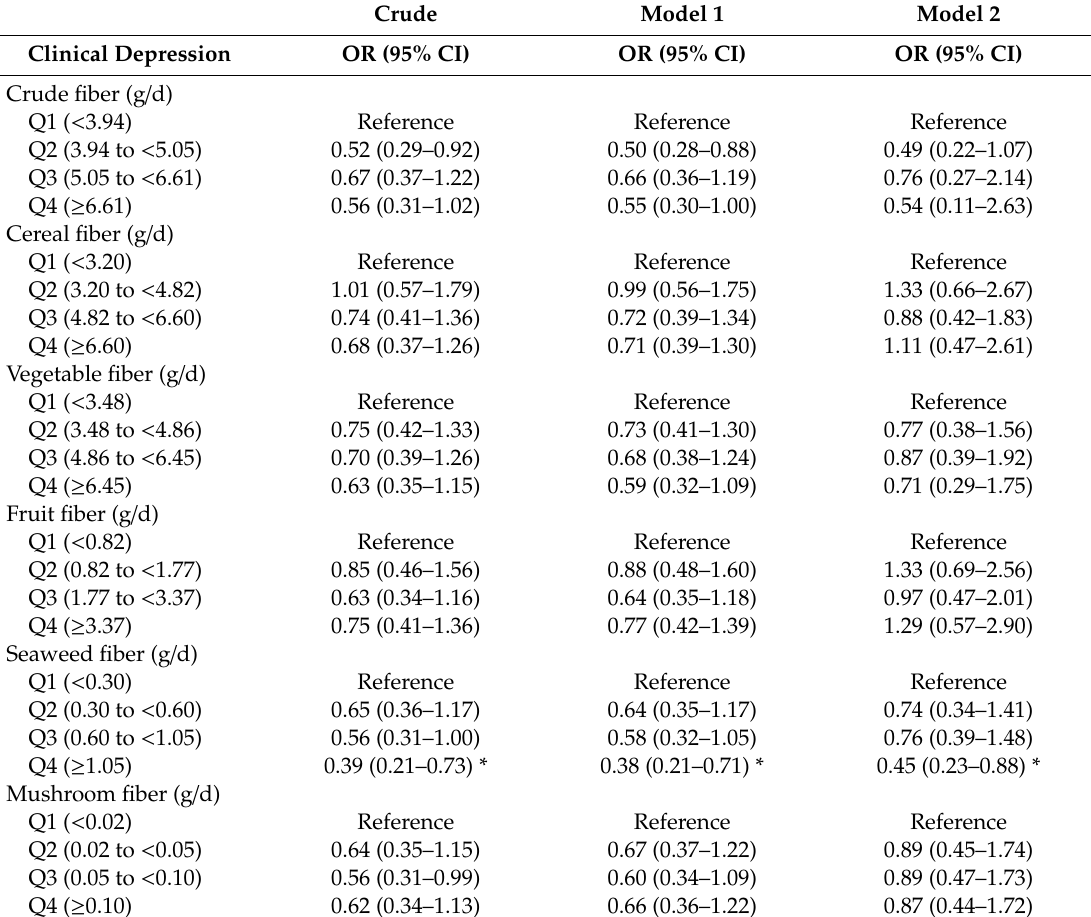
Table 3. Association between clinical depression and dietary fiber intake (KNHANES